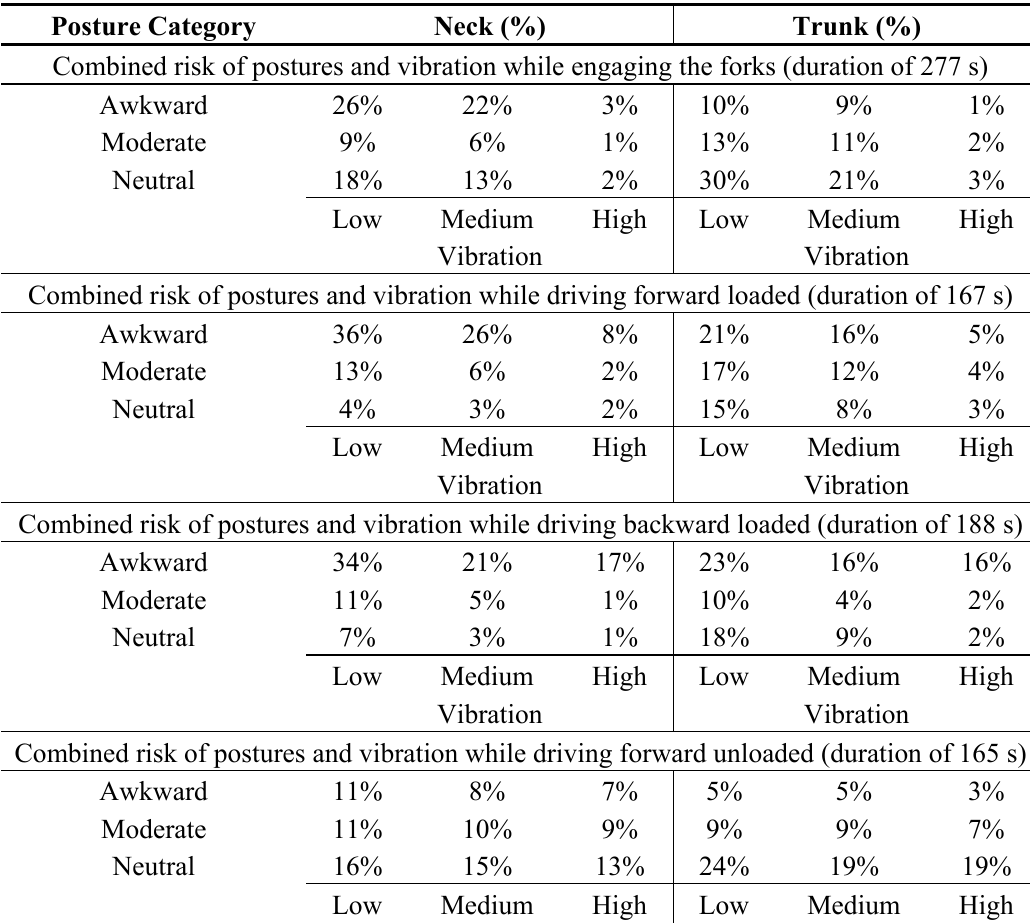
Table 1. Sample contingency tables showing the relationship between posture and vibration; the percent of time spent in the various combinations is listed. The numbers in the left-hand column describe the neck while the numbers in the right-hand column describe the trunk. The top row describes this relationship for the “engaging the forks” task, the second row describes the driving forward while loaded task, the third row describes driving backwards while loaded task and the bottom row describes the driving forward unloaded task. Apparent trends include a greater proportion of time in awkward postures in the backward driving compared to forwards, and a greater vibration exposure when driving unloaded compared to loaded. Although the trends are similar between the neck and the trunk, the neck typically shows a greater proportion of awkward